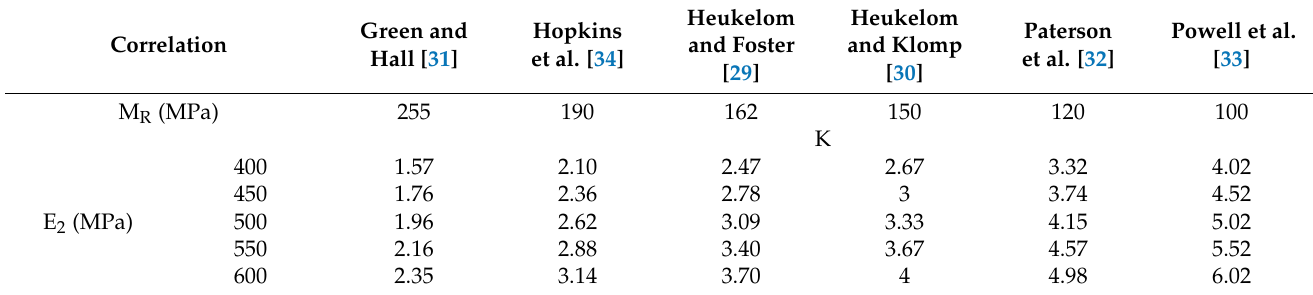
Table 6. Values of coefficient k, based on E 2 values, per M R –CBR correlation.